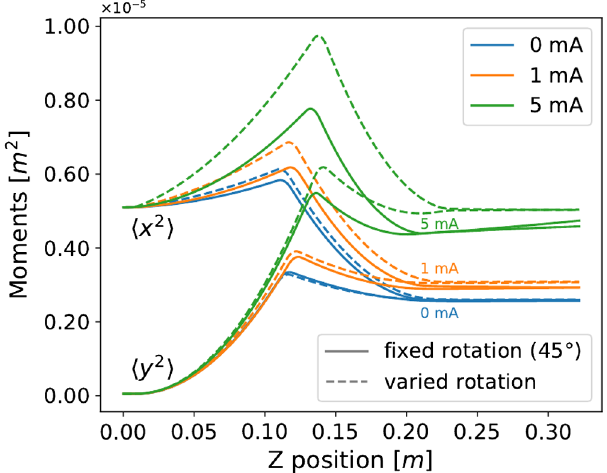
FIG. 6. rms beam size vs longitudinal position for optimizations that used varied quadrupole rotation angles (dashed lines) as well as fixed 45-degree rotation angles (solid lines). Optimizations are run for 0, 1, and 5 mA beam currents with 5 keV beam